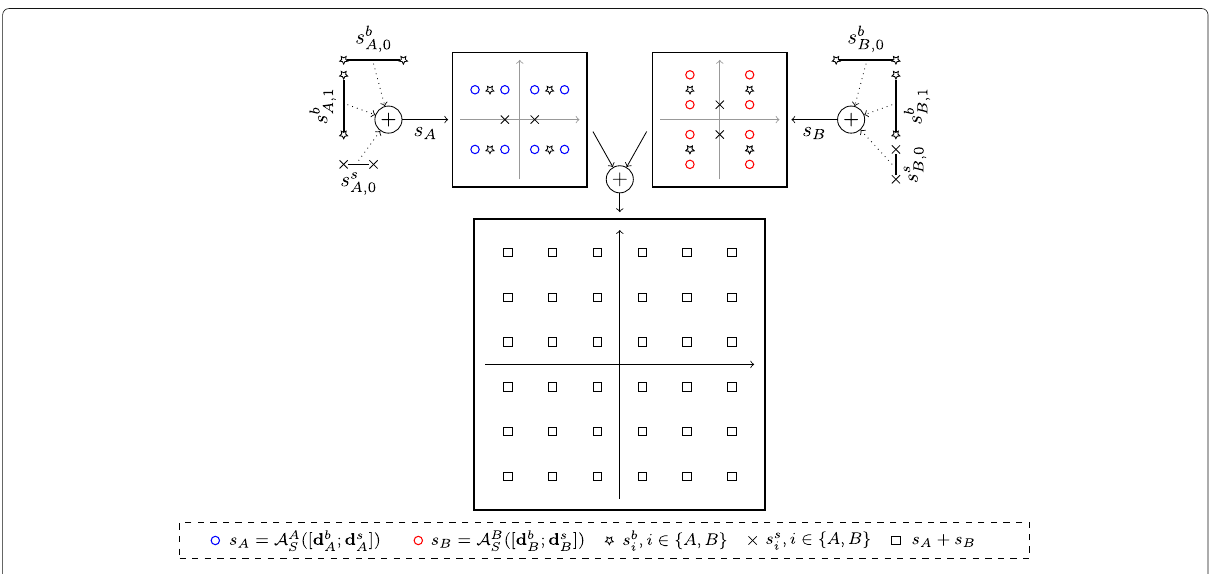
Fig. 3 Source constellation design example for N b = 2, N s = 1. Resulting constellations are depicted as blue circles ( S A output constellation), red circles ( S B output constellation), and squares (received superimposed constellation at R ). Hierarchical function is f